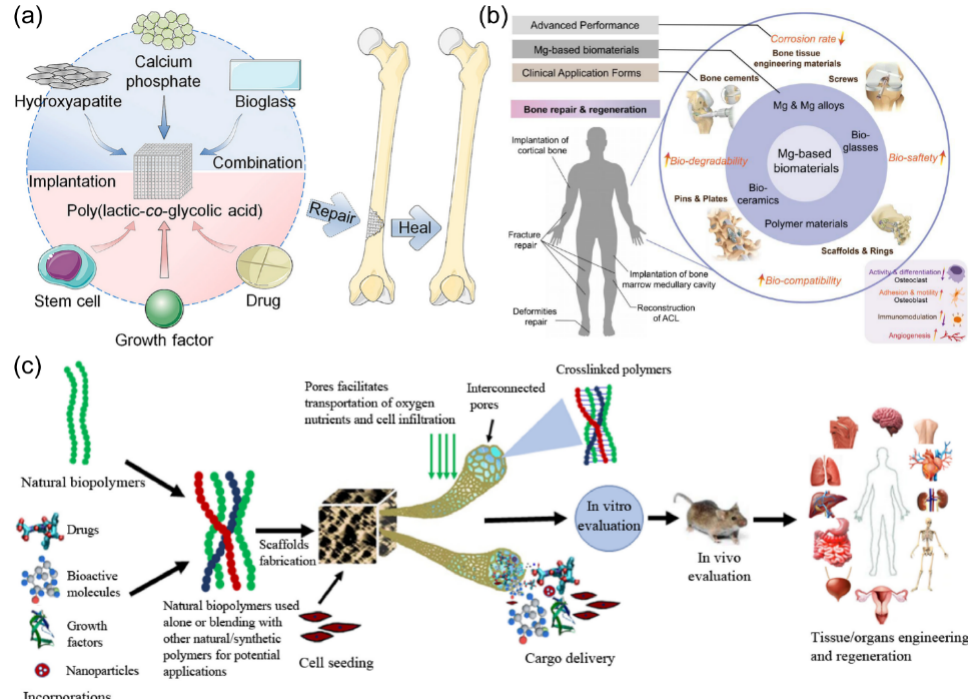
Figure 1. ( a ) Poly(lactic-co-glycolic acid)-based bone-substitute materials for bone repairing and healing. ( b ) Biomedical application of Mg-based biomaterials and their corresponding physiological processes. ( c ) The fabrication and role of biomaterials in the delivery of cells, bioactive molecules, growth factors, and drugs for tissue engineering applications. (Reproduced with permission from [3,14,15]. Copyright (2021), Elsevier.)